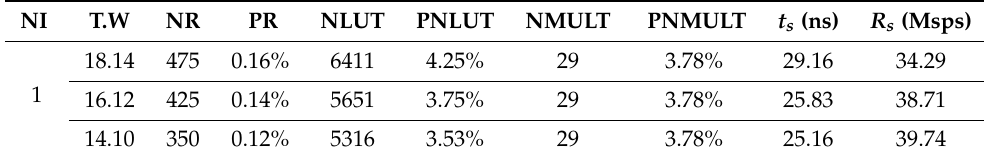
Table 8. Synthesis results regarding the hardware area occupation, processing time, and throughput for the BP module and varying the number of